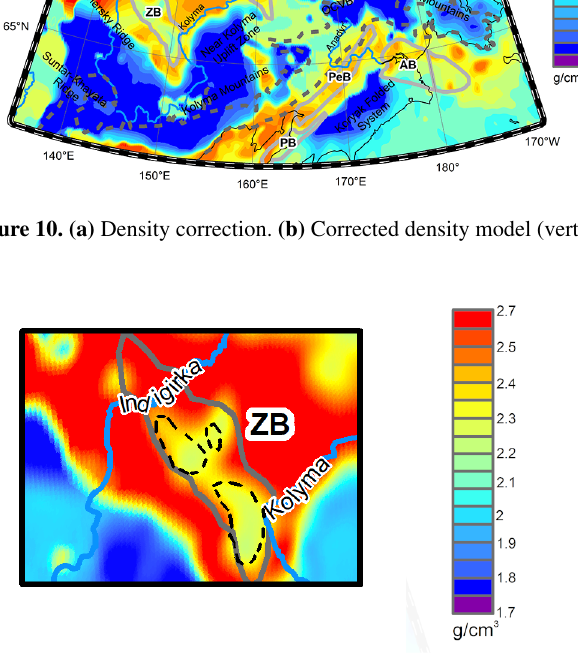
Figure 11. New density model zoomed in on the Zyryanka Basin. Dashed lines show the Lower Cretaceous coal-bearing